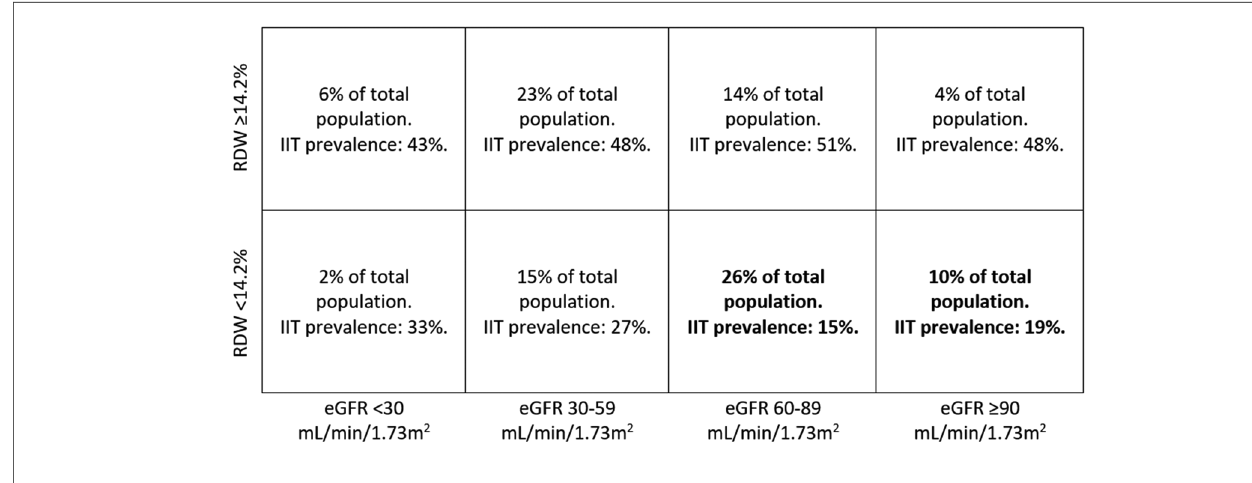
FIGURE 2 Sensitivity, speci fi city, positive predictive value and negative predictive value in the study population, divided based on the eGFR (MDRD) values. HF, heart failure; eGFR, estimated glomerular fi ltration rate; RDW, red cell distribution width; TAST, transferrin